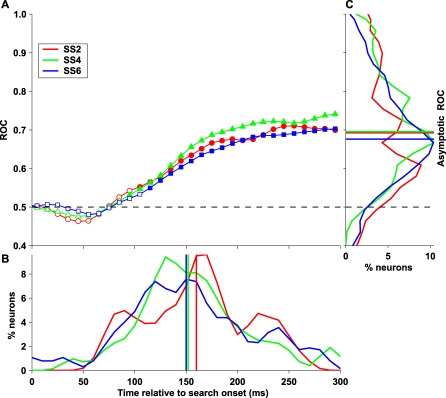
Target Location Selectivity(A) ROC indices reflecting neuronal discrimination between target and distractor for set-size 2 (red circles), 4 (green triangles), and 6 (blue squares). Points show the average indices across the 50 neurons tested at all three set sizes. Filled symbols indicate statistically significant ROC values (p < 0.05 relative to 0.5, t-test).(B) Distributions of times at which discrimination between target and distractor became reliable on a neuron-by-neuron basis for set-size 2 (red), 4 (green), and 6 (blue). The vertical lines indicate medians.(C) The distribution of asymptotic ROC values calculated as the average ROC values in a 200–300 ms interval after the search onset for each neuron and each set size. Lines indicate medians.